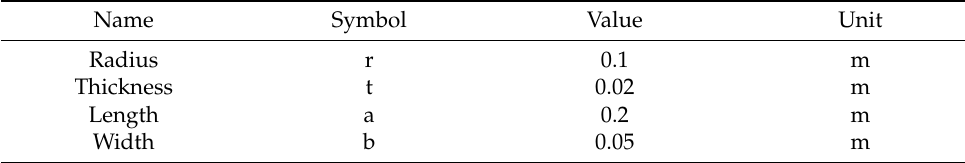
Figure 12. Structure of silicone rubber flexible finger. ( a ) Entire structure; ( b ) cross-section shape. Table 3. Parameters in Figure